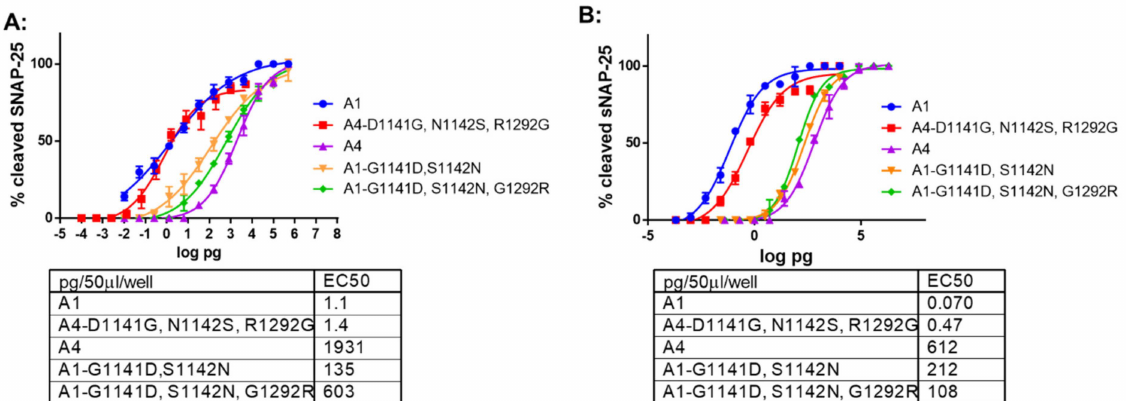
Figure 4. Neuronal cell-based assays of BoNT/A1 and /A4 variant proteins. ( A ) Potency of BoNT/A1 and BoNT/A4 variants in primary rat spinal cord neurons. ( B ) Potency of BoNT/A1 and BoNT/A4 variants in human iPSC derived motor neurons. Neurons were exposed to the toxins for 48 h, and cell lysates analyzed for SNAP-25 cleavage by Western blot. The percent cleaved SNAP-25 was determined by densitometry, and average values and standard deviations were plotted in GraphPad Prism 6, n = 3. EC50 values were derived from a nonlinear four-parameter regression curve fit in GraphPad Prism 6 (Dotmatics, San Diego, CA,